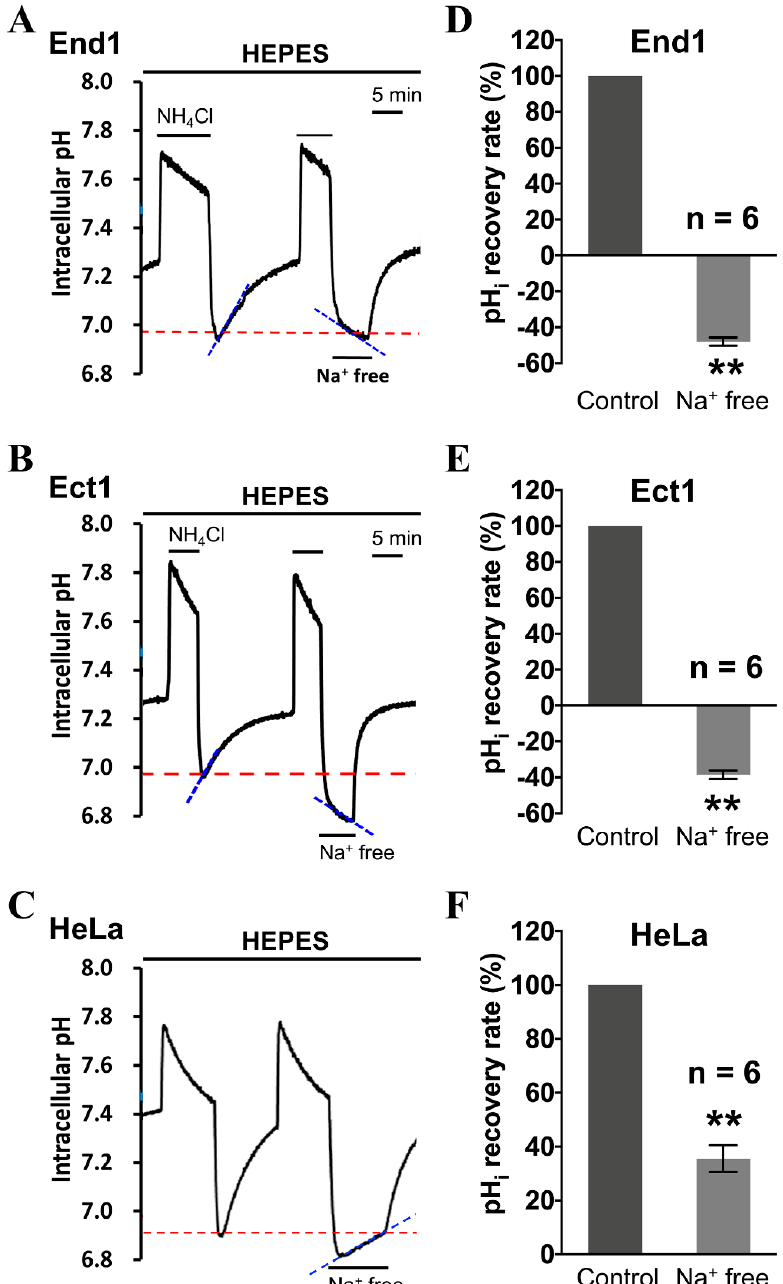
Figure 2. Effect of Na + -free solution on intracellular pH (pH i ) recovery subsequent induced intracellular acidification in HEPES-buffered condition in the End1, Ect1, and HeLa cells. ( A – C ) The top bars show the buffer system used, and the bars above or below the trace show the application of NH 4 Cl and treatment, respectively. ( D – F ) Histograms show the pH i recovery slope (%) following induced intracellular acidification averaged for six experiments similar to those shown in A – C , respectively. The pH i recovery rate was measured at pH i = 6.96 ± 0.08, the level of significance was set at ** p < 0.005 versus the control. Error bars represent the mean ± SEM (standard error mean).